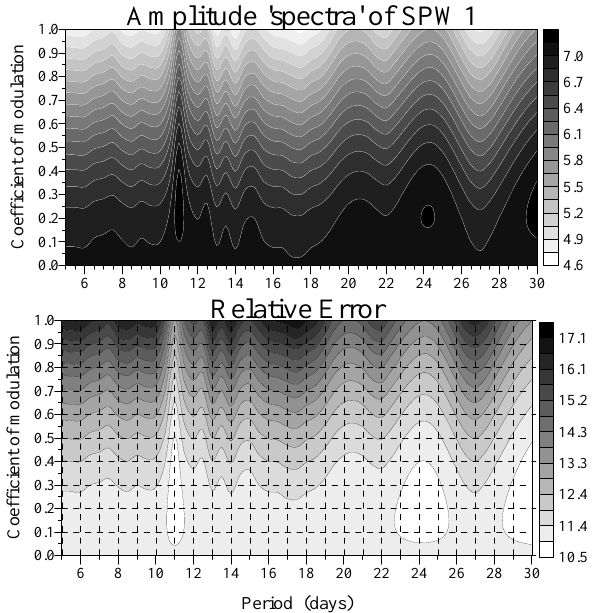
Figure 3 Fig. 3. The same as Fig. 1 but the calculations are done for the UKMO temperature data shown in Fig. 2 and the procedure for least squares best fitting is performed for periods of the modulating os- cillation from 5 to 30 days with a step of 0.5